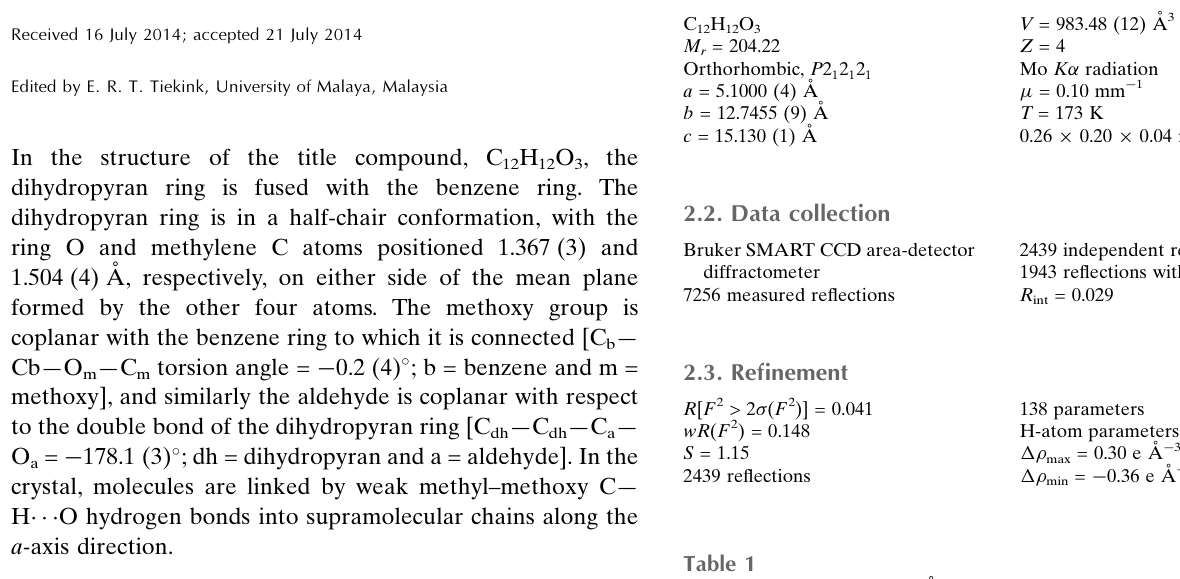
Hydrogen-bond geometry (A˚ , (cid:3)